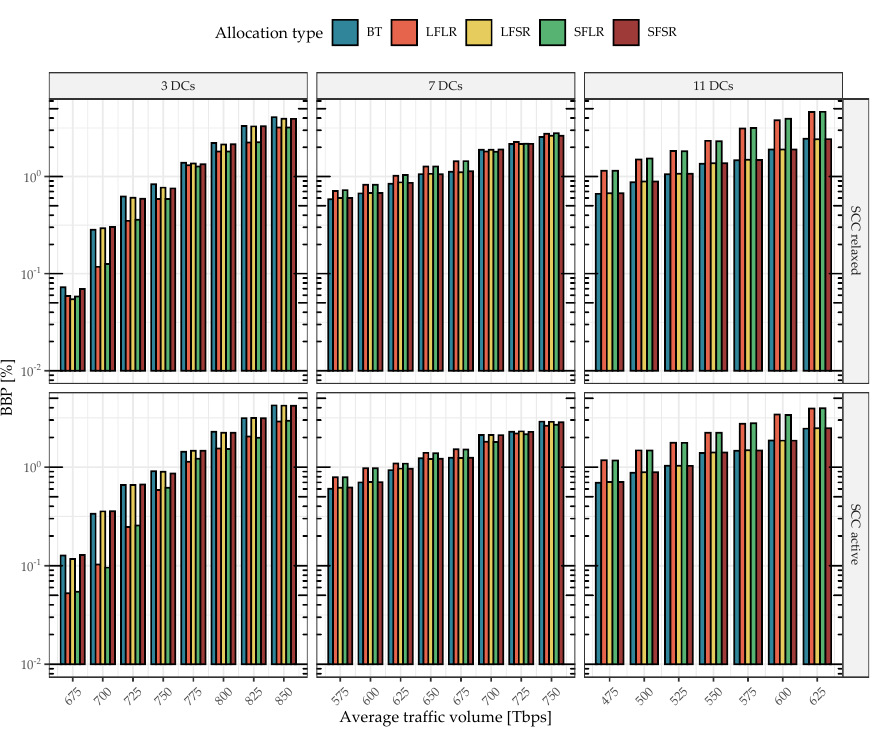
Figure 4. BBP as a function of the average traffic volume for various grooming strategies for the kFF-TG algorithm.